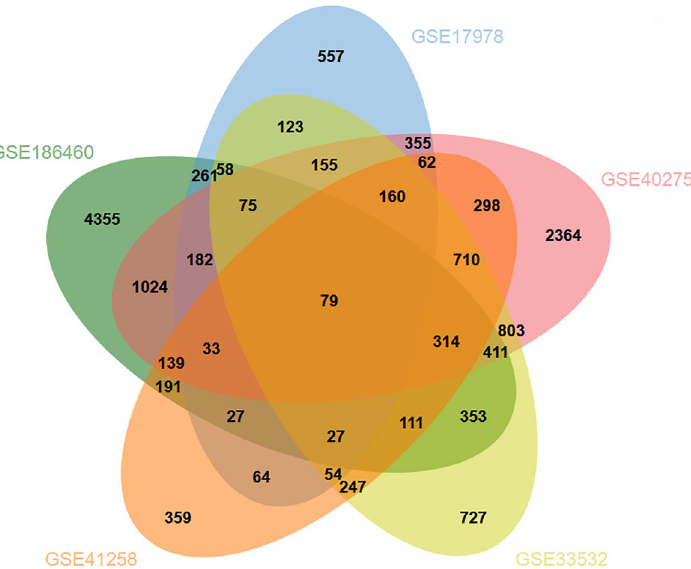
Figure 1. Among the datasets included in this study, IPF (GSE17978), COVID-19 (GSE186460), SCLC (GSE40275), NSCLC (GSE33532), and CRC lung metastasis (GSE41258) are analyzed using microarrays and RNA-seq. Based on this integrated analysis, we discovered 79 DEGs that are common among IPF, COVID-19, SCLC, NSCLC, and CRC lung